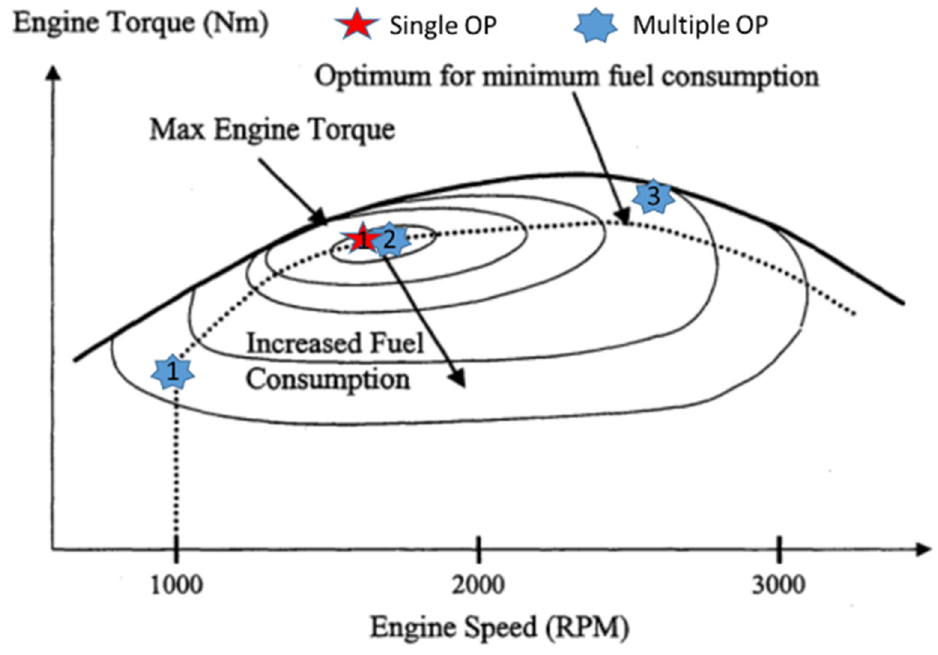
Figure 4. The selected engine operating conditions for serial hybrids.